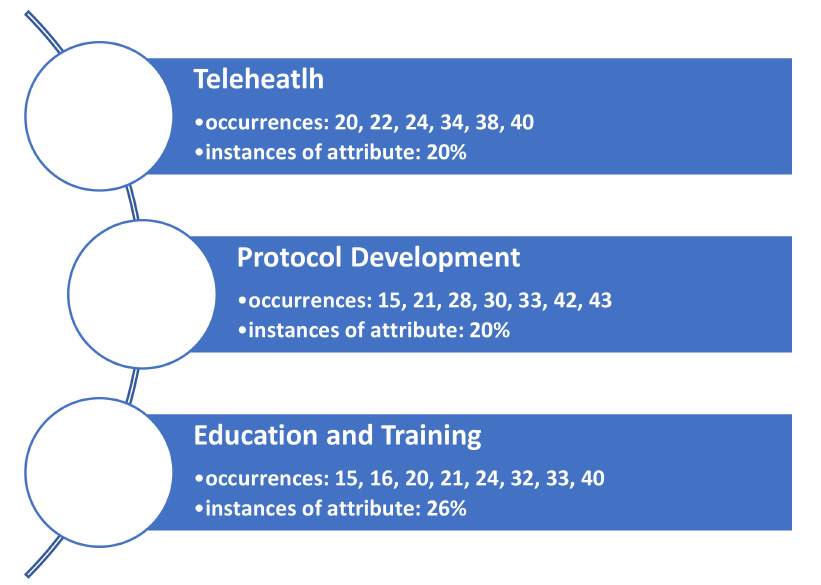
Figure 2. Identified themes (constructs) identified as facilitators leading to an increase in patient throughput in ambulatory care organizations during COVID-19.